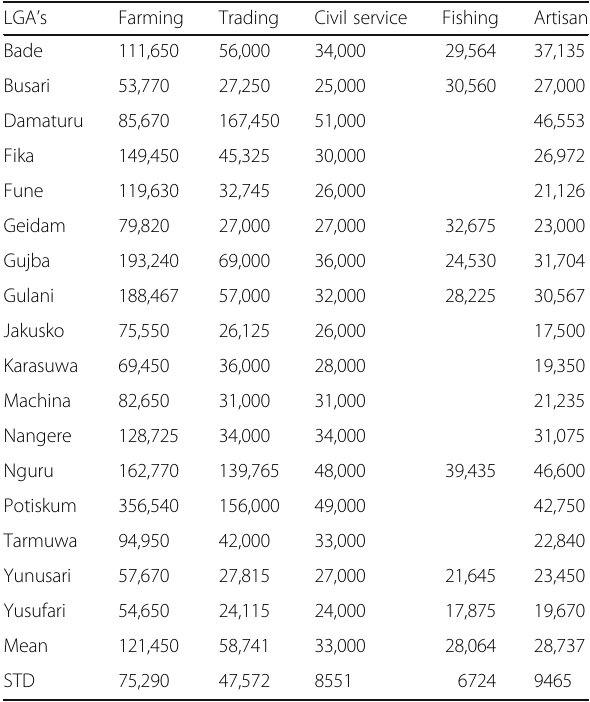
Table 6 Annual Income of the Respondents from